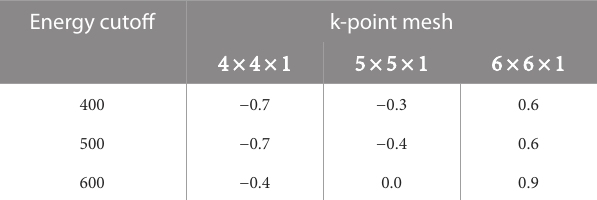
TABLE1 Calculatedtotalenergydifference(meV/atom)forCu(110)system